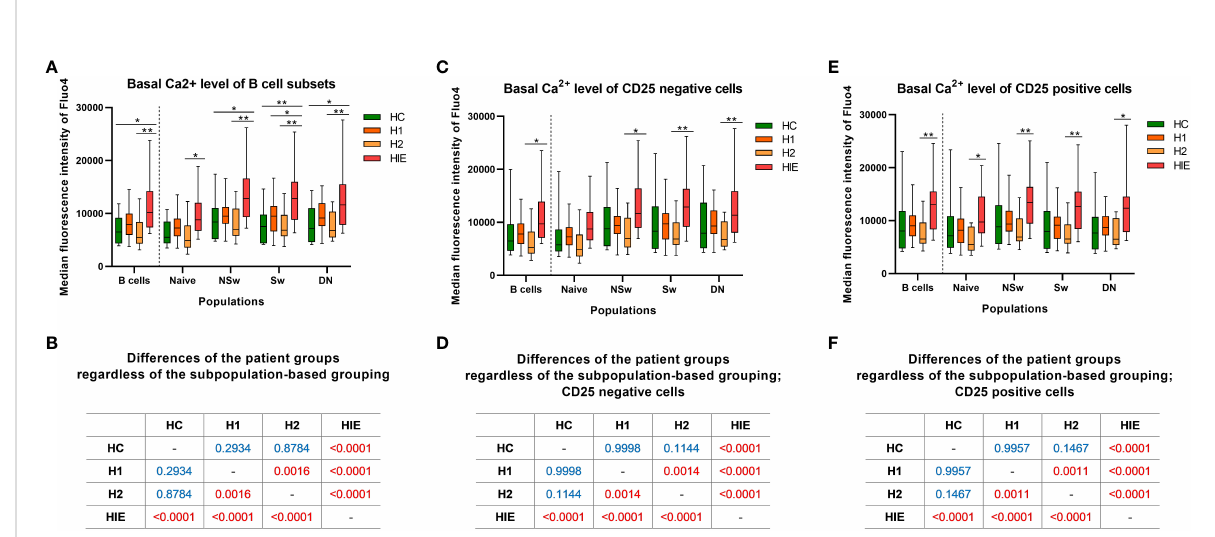
FIGURE 3 Basal calcium level is elevated in B cells from ATA+, euthyroid, infertile patients Baseline median fl uorescence intensity of Fluo4 in B cell subpopulations (A) , CD25- (C) and CD25+ (E) B cells. Cross tabulation shows the p values when comparing patient groups without the subpopulation-based grouping of B cells (B) , CD25- (D) and CD25+ cells (F) . HC: healthy controls (n=12); HT: Hashimoto ’ s thyroiditis, H1: hypothyroid patients with HT before treatment (n=14); H2: euthyroid patients with HT, after levothyroxine-treatment, (n=12); HIE: HT, infertile, euthyroid patients (n=14); NSw: non-switched; Sw: switched, DN: double negative memory B cells. Differences between the groups and within the B cell subpopulations were assessed with two-way ANOVA and Tukey ’ s post hoc test except H1-H2 comparisons, where a mixed-effects analysis and the Sidak ’ s multiple comparisons test were